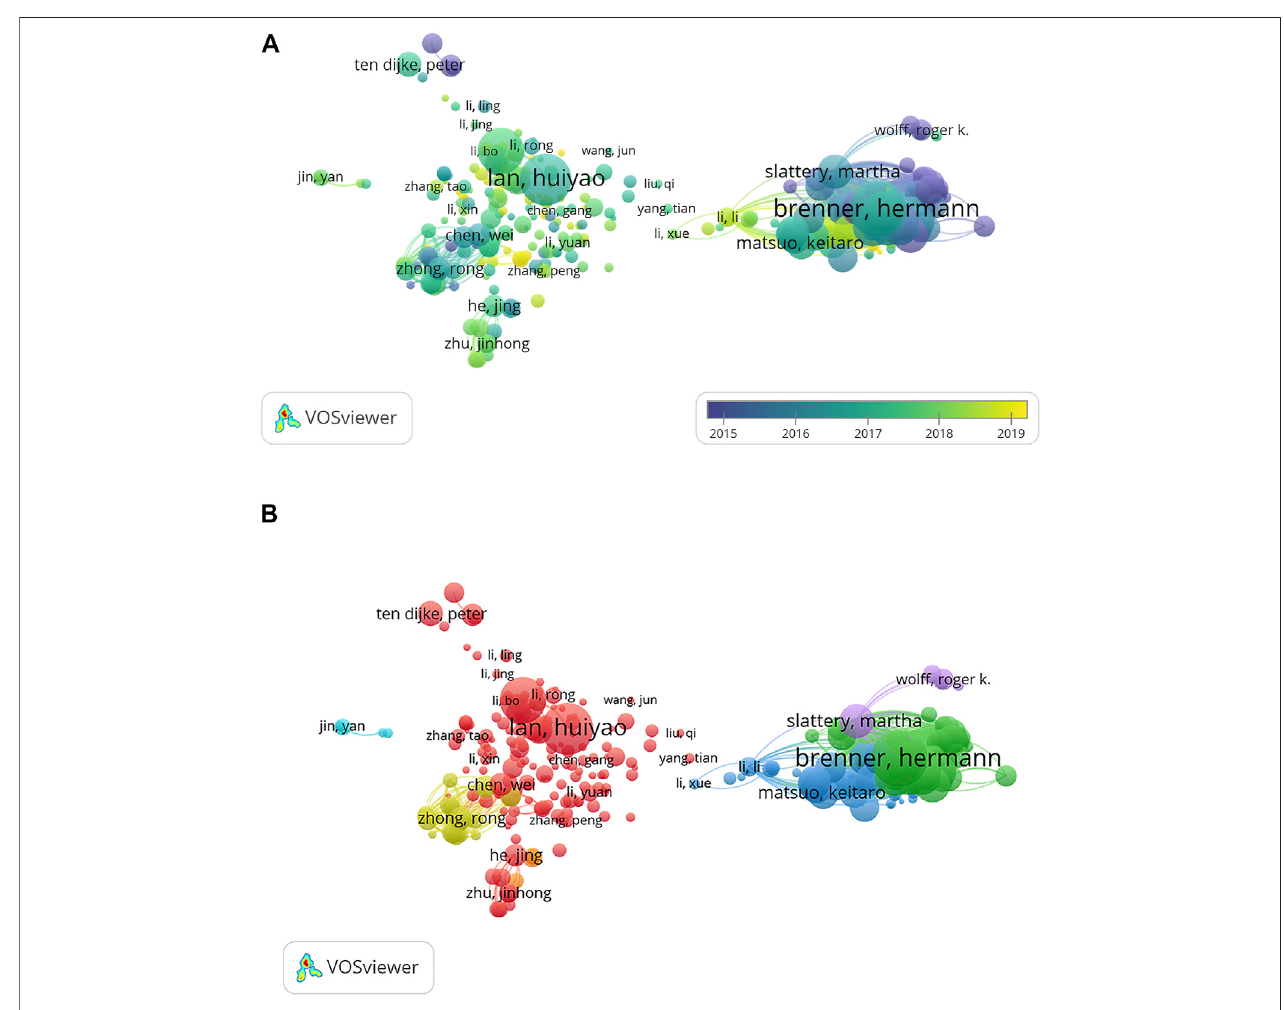
FIGURE 5 | Visualization graphs of co-authorship analysis of authors. (A) Overlay visualization of authors involved in studies on SMAD7 in oncology. (B) Network visualization of authors involved in studies on SMAD7 in oncology. Figure 5A Footnote: The analysis method was Linlog/modularity in VOSviewer, the weight was citations,andscoresweretheaveragepublicationyear.Thethicknessofthelinesindicatesthestrengthoftherelationship.Thecolormeanstheaveragepublicationyear. Figure 5B Footnote: The total authors were classi fi ed into 7 clusters with different colors to show several major cooperative groups.